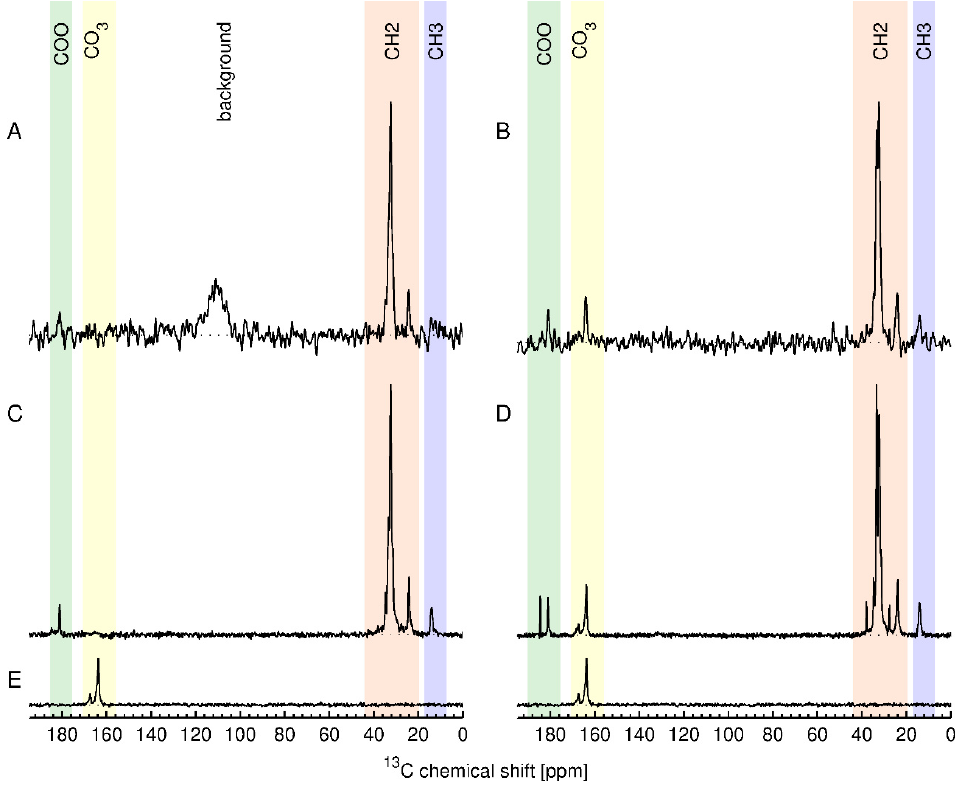
Figure 8. 13 C solid-state NMR spectra of USRN-06-C18 (A, C), USRN-07-C18 (B, D) and USRN-02 (E). (A) and (B) are direct polarization (DP) spectra, whereas (C–E) are cross-polarization (CP) spectra.